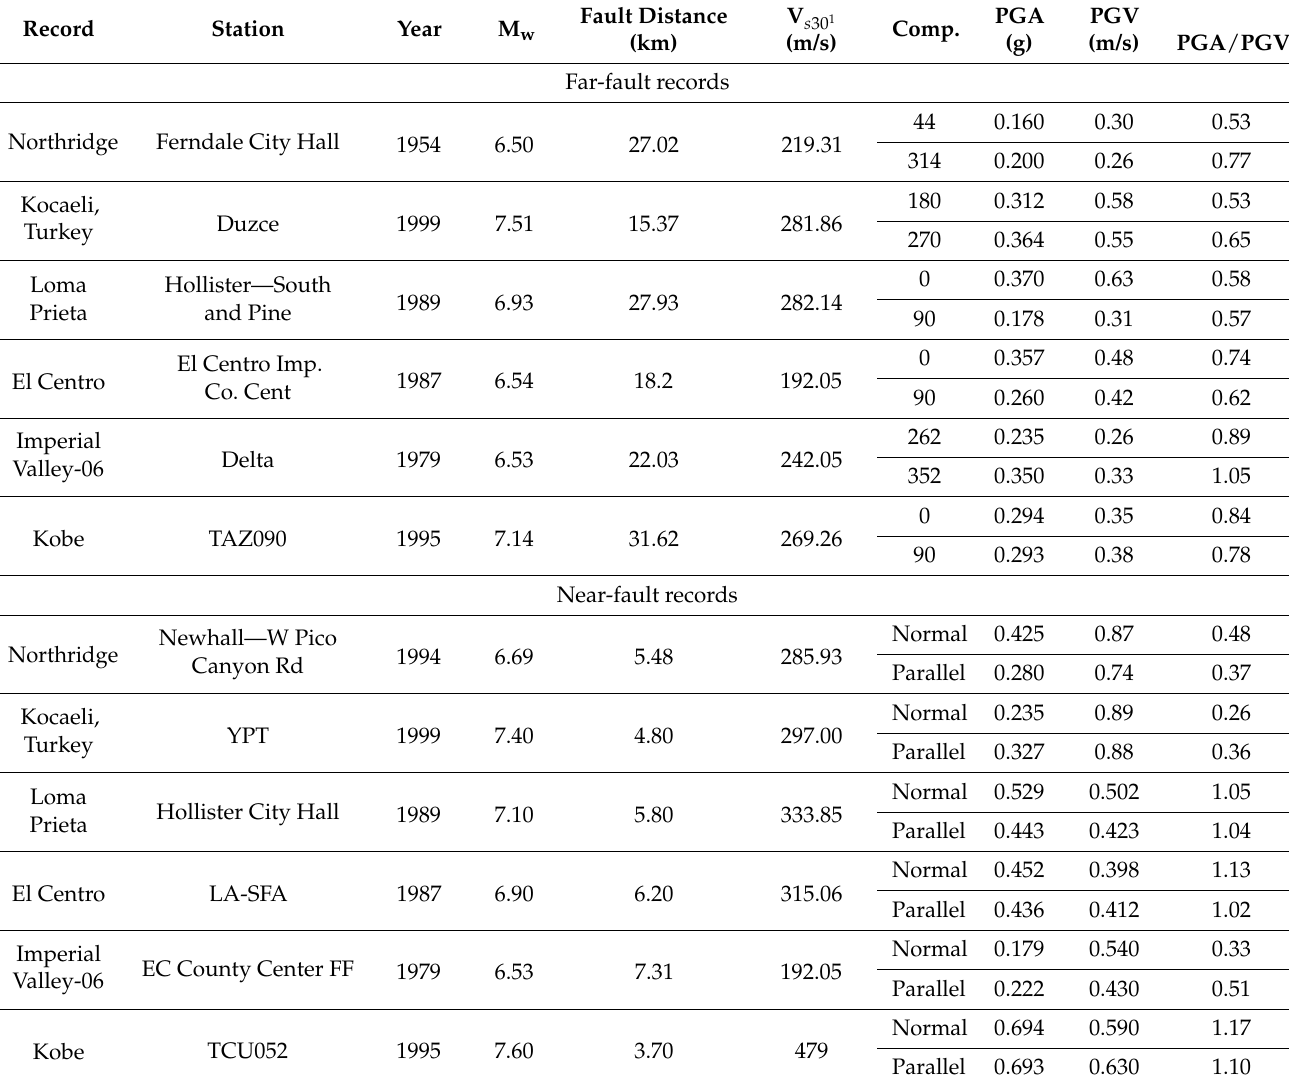
Table 2. Used ground motion